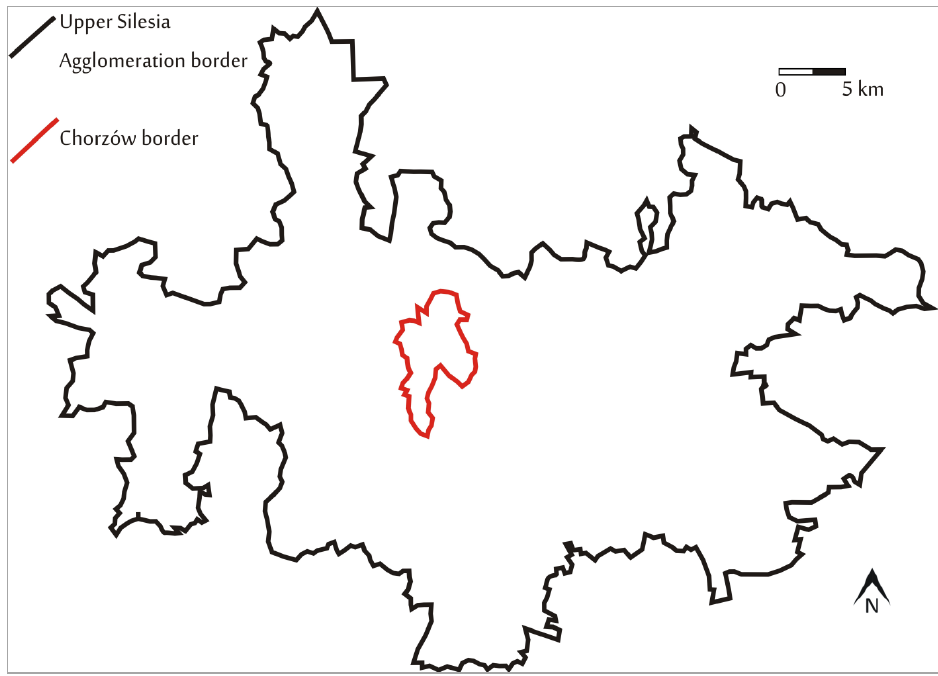
Fig. 1. The location of the study